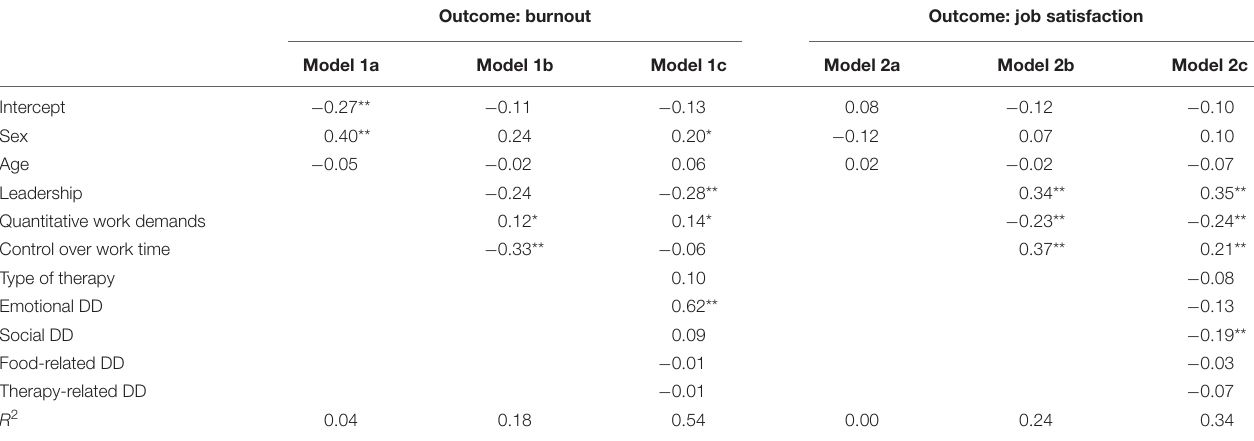
TABLE 3 | Models regressing the standardized outcomes on standardized